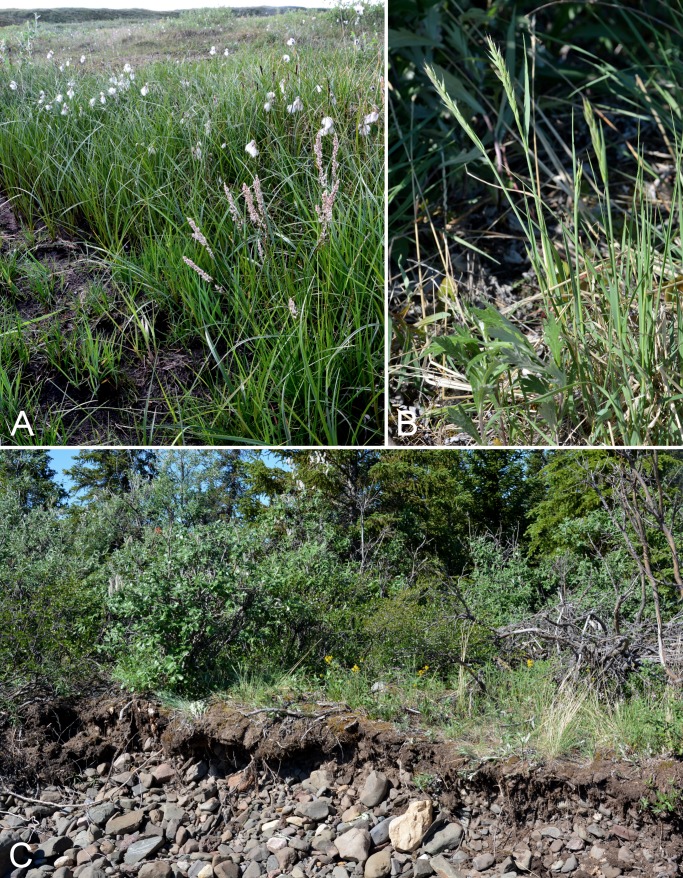
Deschampsia brevifolia and Elymus alaskanus subsp. alaskanus.Deschampsia brevifolia: (A) habit (bottom right), Saarela et al. 4098. Elymus alaskanus subsp. alaskanus: (B) habit, Saarela et al. 3191. (C) Habitat, Saarela et al. 3191. Photographs by P. C. Sokoloff.